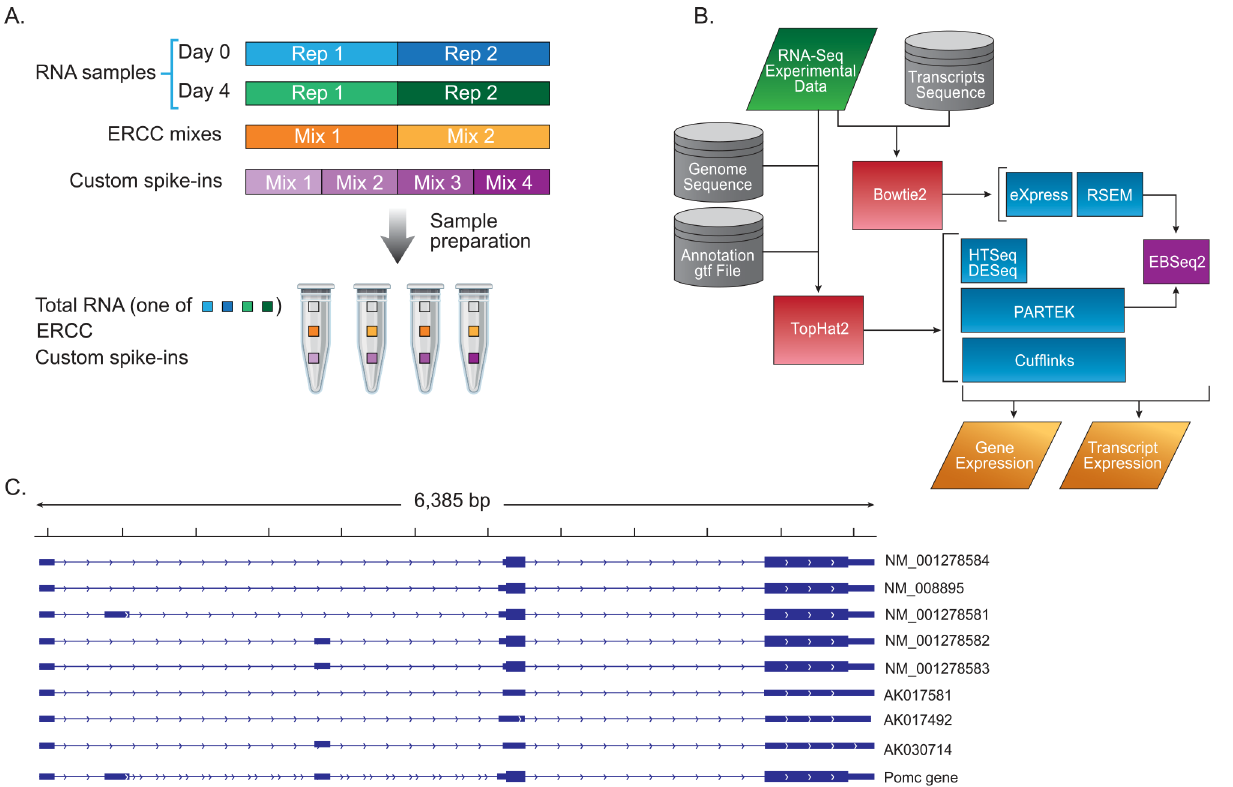
Fig 1. Experiment and analysis design. (A) Illustration of the experimental sample preparation. The experiment consisted of four RNA samples, two replicates (designated as Rep) of Day 0 (colored in blue) and two of Day 4 (green), each sample was divided to four vials, to two of them ERCC mix 1 was added and to other two mix 2 (orange). In addition one of the custom IVT spike-ins was added to each vial (violet). In total there were 16 vials. Custom mix 4 is the control without IVT spike-ins. (B) Diagram of the bioinformatics analysis design. (C) Genome browser view depicting the gene locus of Pomc that includes three distinct spike-in transcripts (AK030714, AK017581 and